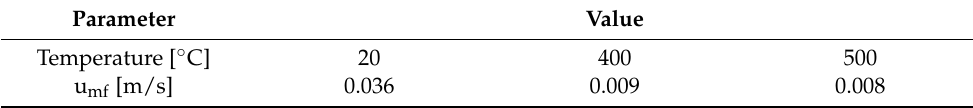
Table 3. Experimental values of minimum fluidization velocity as function of temperature.